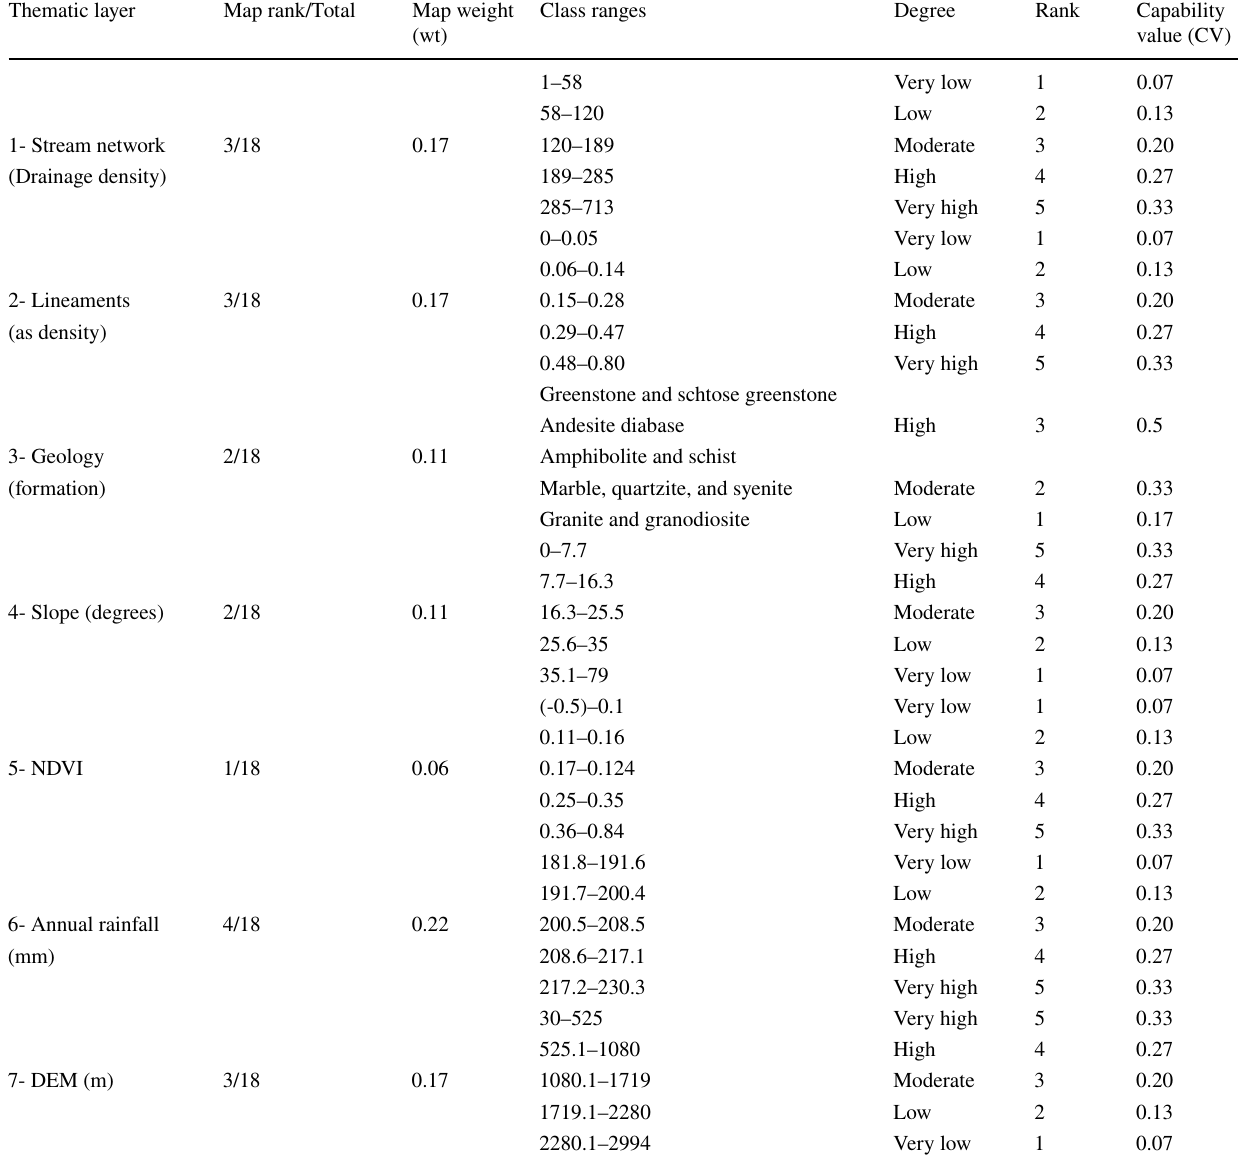
Table 2 Thematic map weights and capability values Thematic